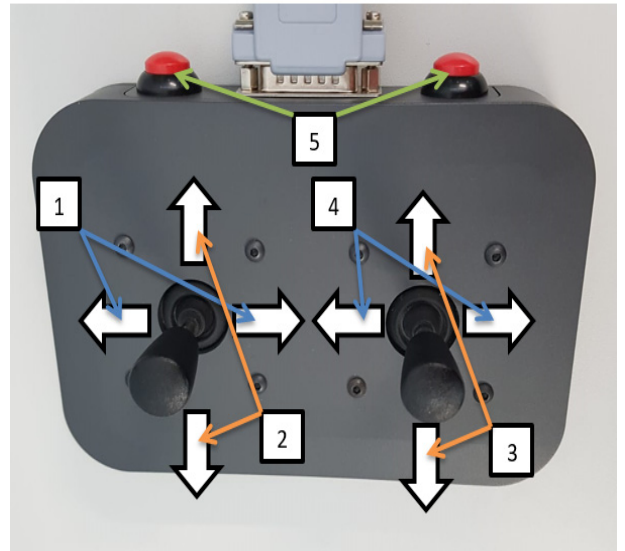
Figure 14. Joystick used to control the MMI4D system. Legend: 1—U1 axis control; 2—U2 axis control; 3—U3 axis control; 4—U4 axis control; 5—gripper control.